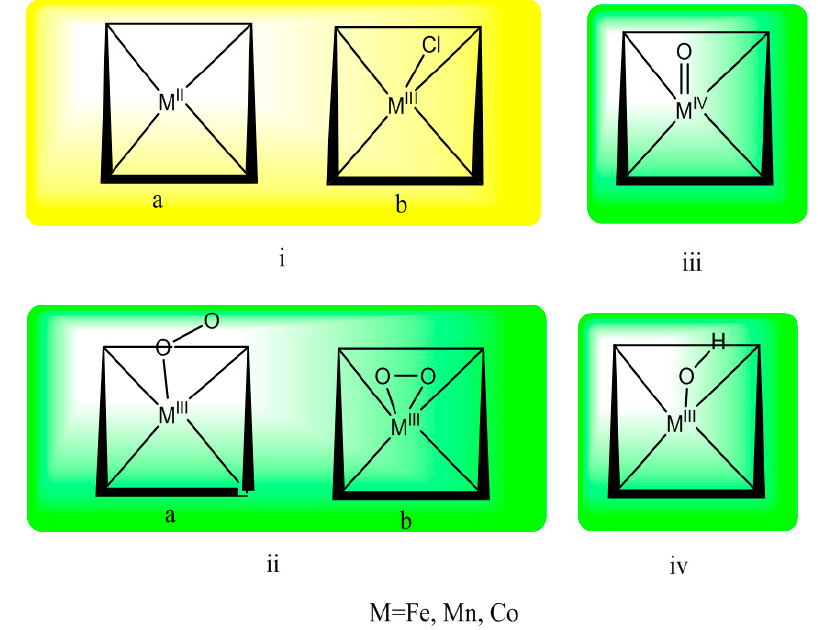
Figure 1. The geometric structure of metalloporphyrins and intermediates: ( i ) metalloporphyrin, PM II , PM III Cl; ( ii ) metal( III )-peroxo complex, PM III -O 2 ; ( iii ) metal( IV )-oxo complex, PM IV O; and ( iv ) metal( III )-hydroxy complex, PM III OH.